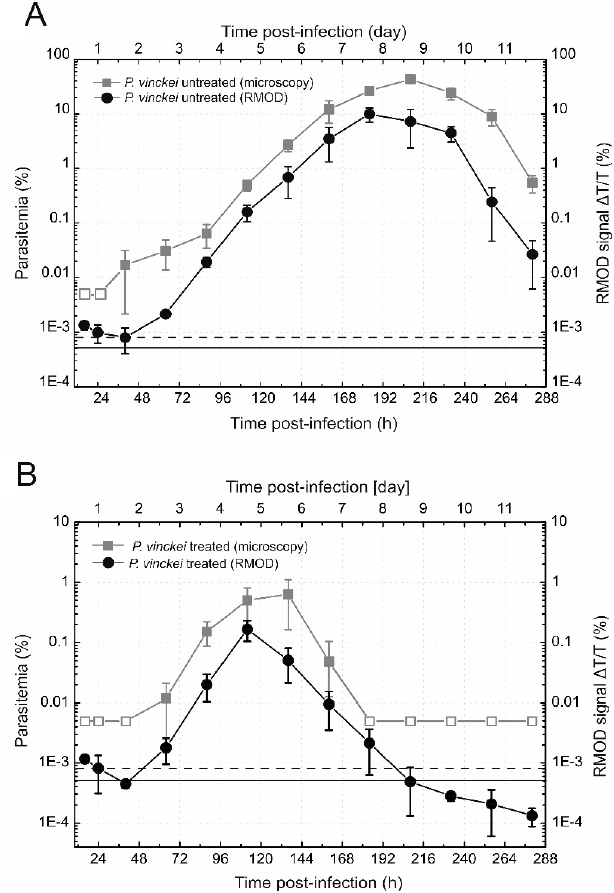
Figure 3. Monitoring of the self-resolving P. vinckei blood-stage infection and its course during chloroquine treatment. ( A ) Monitoring the development of the P. vinckei infection. The gray squares represent the parasitemia values determined by microscopy; the empty squares show samples declared negative after counting 10,000 red blood cells. The black circles represent the RMOD signal. ( B ) Monitoring the effect of chloroquine treatment in P. vinckei infections. The gray squares represent the parasitemia values determined by microscopy; the empty squares show the negative samples. The black circles represent the corresponding RMOD signal. The chloroquine treatment started after the sampling at 112 h post ‐ infection. Both in panel ( A ) and ( B ), each symbol and error bar represents the average and standard deviation of values measured on blood samples from n = 4 mice. The continuous black line represents the average of the RMOD values of ~20 uninfected control samples. The dashed black lines indicate the detection limit defined as the average plus two times the standard deviation of the uninfected values.